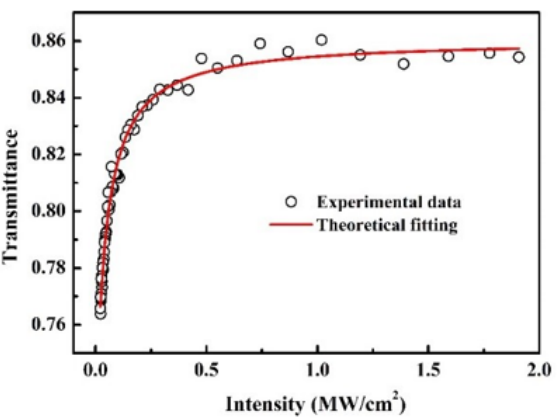
Figure 12. The transmittance versus input energy intensity of Yb 3+ :ScBO 3